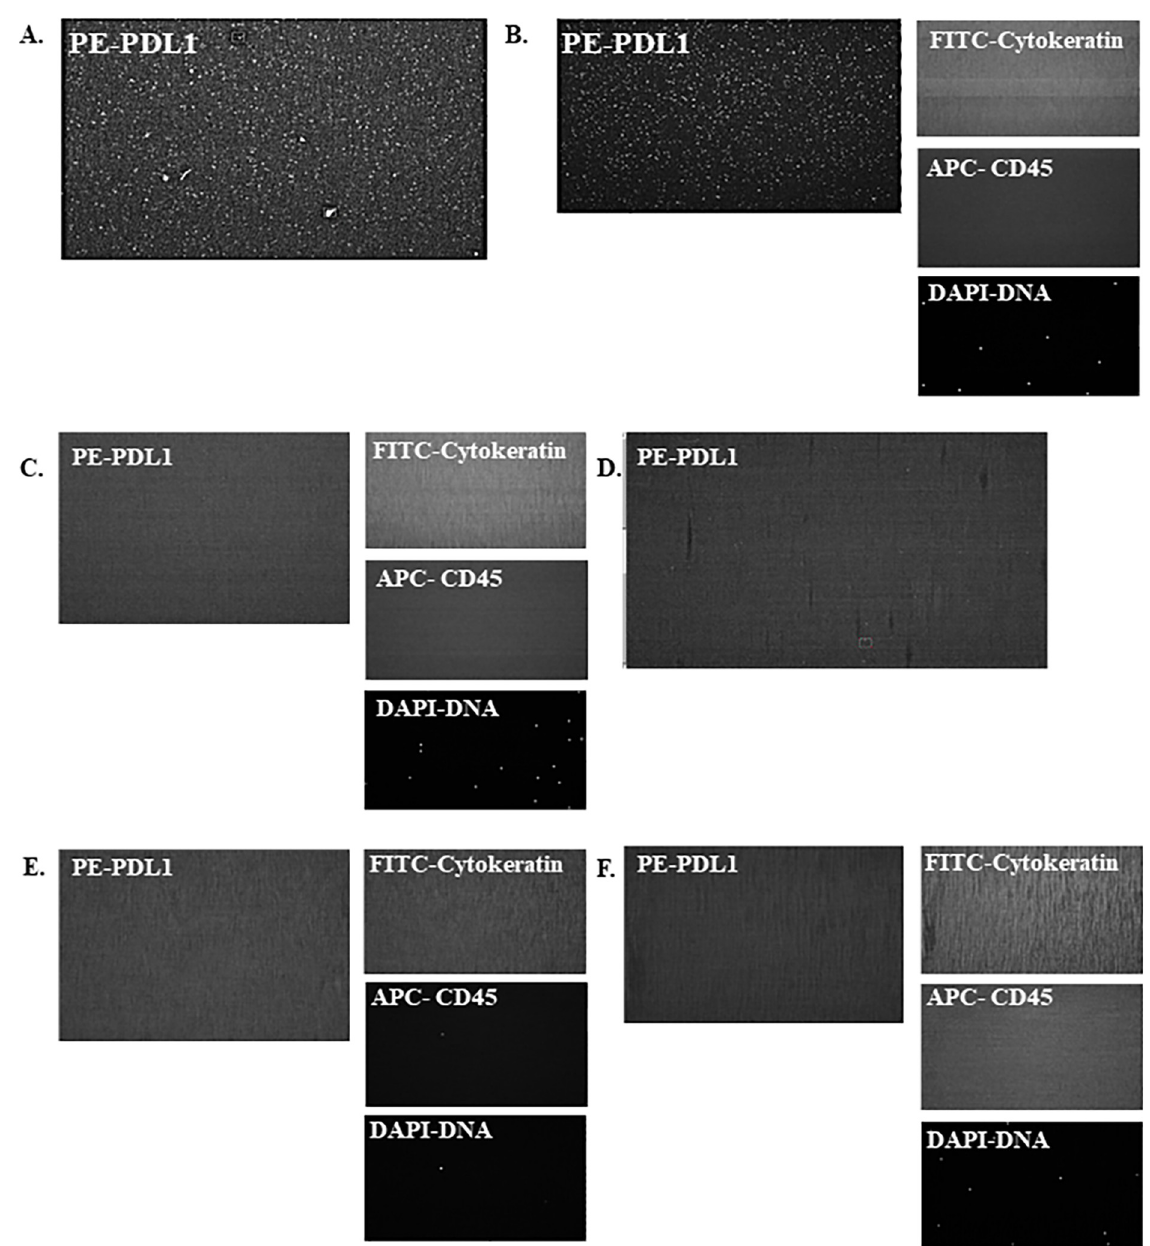
Fig 2. PD-L1 expression on platelets. Whole Blood, a pure platelet pellet, and platelet poor plasma from two patients, one with positive platelet PD-L1 (A) and one with negative platelet PD-L1 (D), was processed through CellSearch 1 in parallel with PD-L1 staining in the 4th channel. A. Fluorescent image of positive platelet PD-L1 (PE conjugated) expression obtained from initial whole blood processed through CellSearch 1 using the classic method. B. Fluorescent images of PD-L1 (PE conjugated), cytokeratin (FITC-conjugated), CD-45 (APC conjugated), and DNA (DAPI) for platelet pellet from patient in panel A with positive platelet PD-L1 processed through CellSearch 1 . C. Fluorescent images of PD-L1 (PE conjugated), cytokeratin (FITC-conjugated), CD-45 (APC conjugated), and DNA (DAPI) for platelet poor plasma from patient in panel A with positive platelet PD-L1 processed through CellSearch 1 . See Methods for details. D. Florescent image of negative platelet PD-L1 (PE conjugated) expression obtained from initial whole blood processed through CellSearch 1 using the classic method. E. Florescent images of PD-L1 (PE conjugated), cytokeratin (FITC-conjugated), CD-45 (APC conjugated), and DNA (DAPI) for platelet pellet from patient in panel D with negative platelet PD-L1 processed through CellSearch 1 . F. Florescent images of PD-L1 (PE conjugated), cytokeratin (FITC-conjugated), CD-45 (APC conjugated), and DNA (DAPI) for platelet poor plasma processed from patient in panel D with negative platelet PD-L1 through CellSearch 1 .